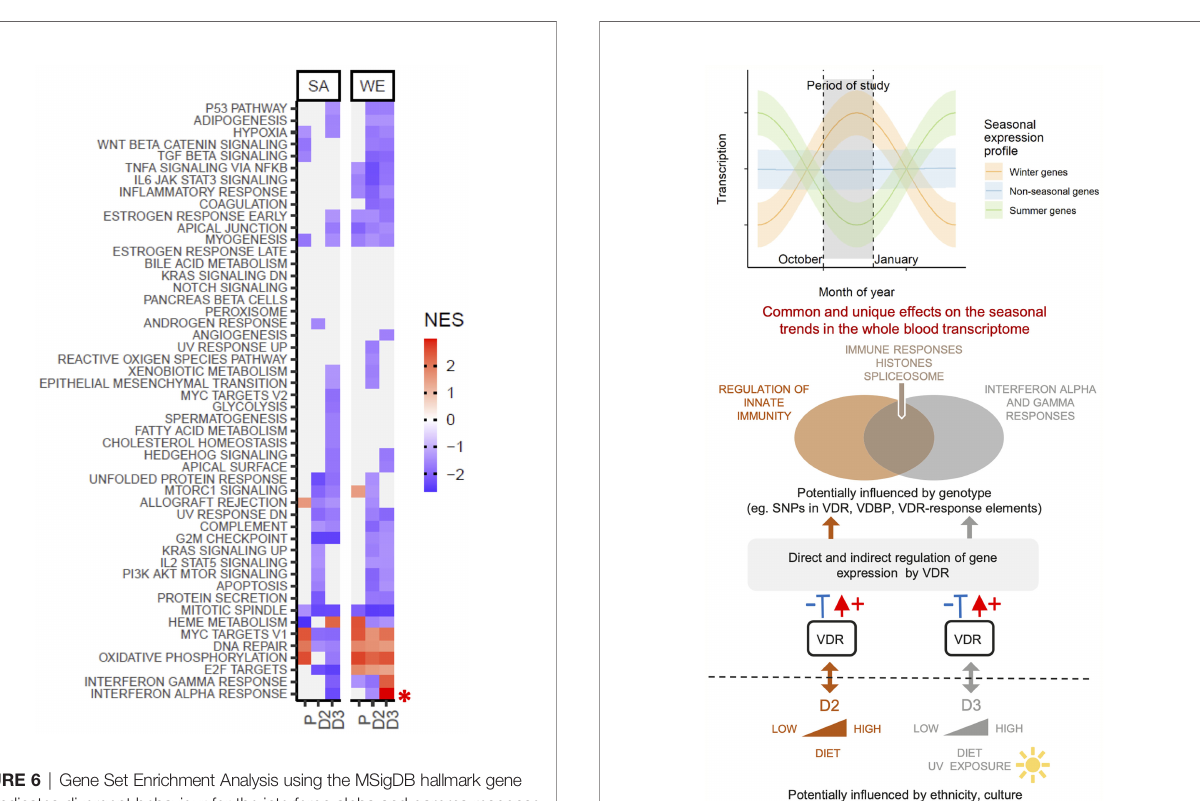
FIGURE 6 | Gene Set Enrichment Analysis using the MSigDB hallmark gene sets indicates divergent behaviour for the interferon alpha and gamma response gene sets following supplementation with vitamin D 2 and D 3 in the WE cohort. Coloured tiles in the heatmap correspond to gene sets exhibiting a statistically signi fi cant (padjust ≤ 0.05), concordant change between the V3 and V1 sampling times for the placebo (P), vitamin D 2 (D2) or vitamin D 3 (D3) treatment groups in the SA or WE cohorts. Grey tiles indicate non-signi fi cance. A positive normalised enrichment score (NES) indicates up-regulation of a gene set in V3 relative to V1, and conversely down-regulation is indicated by a negative NES score. Full results are provided in Supplementary Data File 9 , and the behavior of the leading edge, core genes accounting for the signi fi cant enrichment signals in the interferon alpha and gamma response sets are